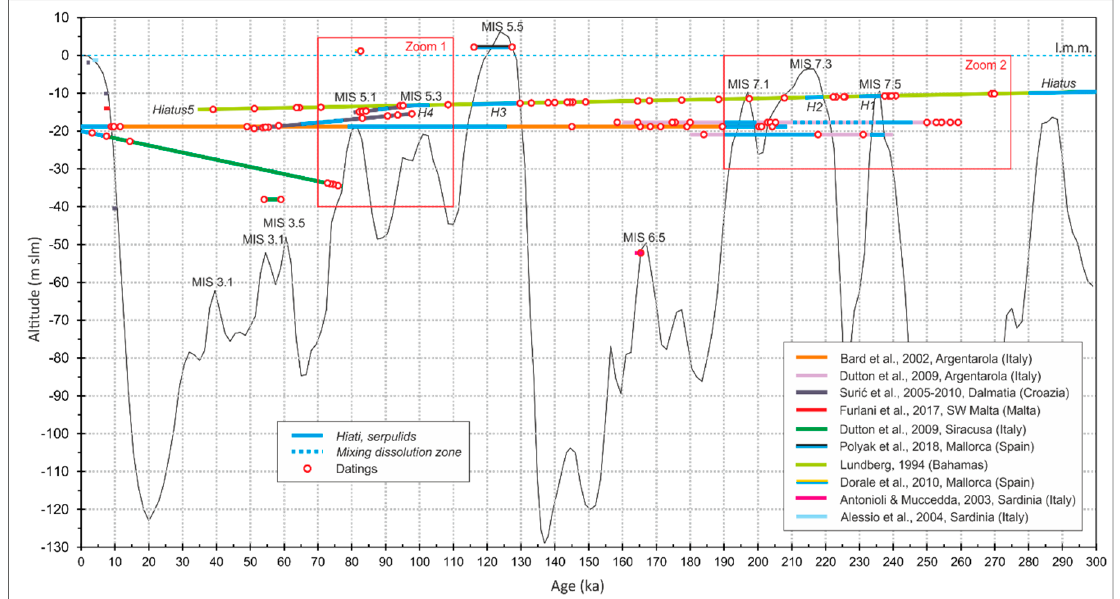
Figure 13. Elevations and radiometric ages ( 14 C and U-Th) of the Mediterranean speleothems and marine overgrowths discussed in the present study and a comparison with the DWBAH flowstone Table A1. Argentarola (Italy), − 18.5 m [2] and − 18 and − 21.7 m [22]; Plemmirio (Italy), − 23 m [64]; Grotta di Nettuno (Italy), − 3 m [81]; U vode Pit (Krk Island, Croatia), Stalagmite K − 4 ( − 14.5 m) and K-18 ( − 18.8 m) [3]; POS from Mallorca (Spain), + 1.5 m [4,5]; Malta [65]; DWBAH Flowstone (Bahamas), − 15 m [11]. Black line: global sea level curve reconstructed by [88].